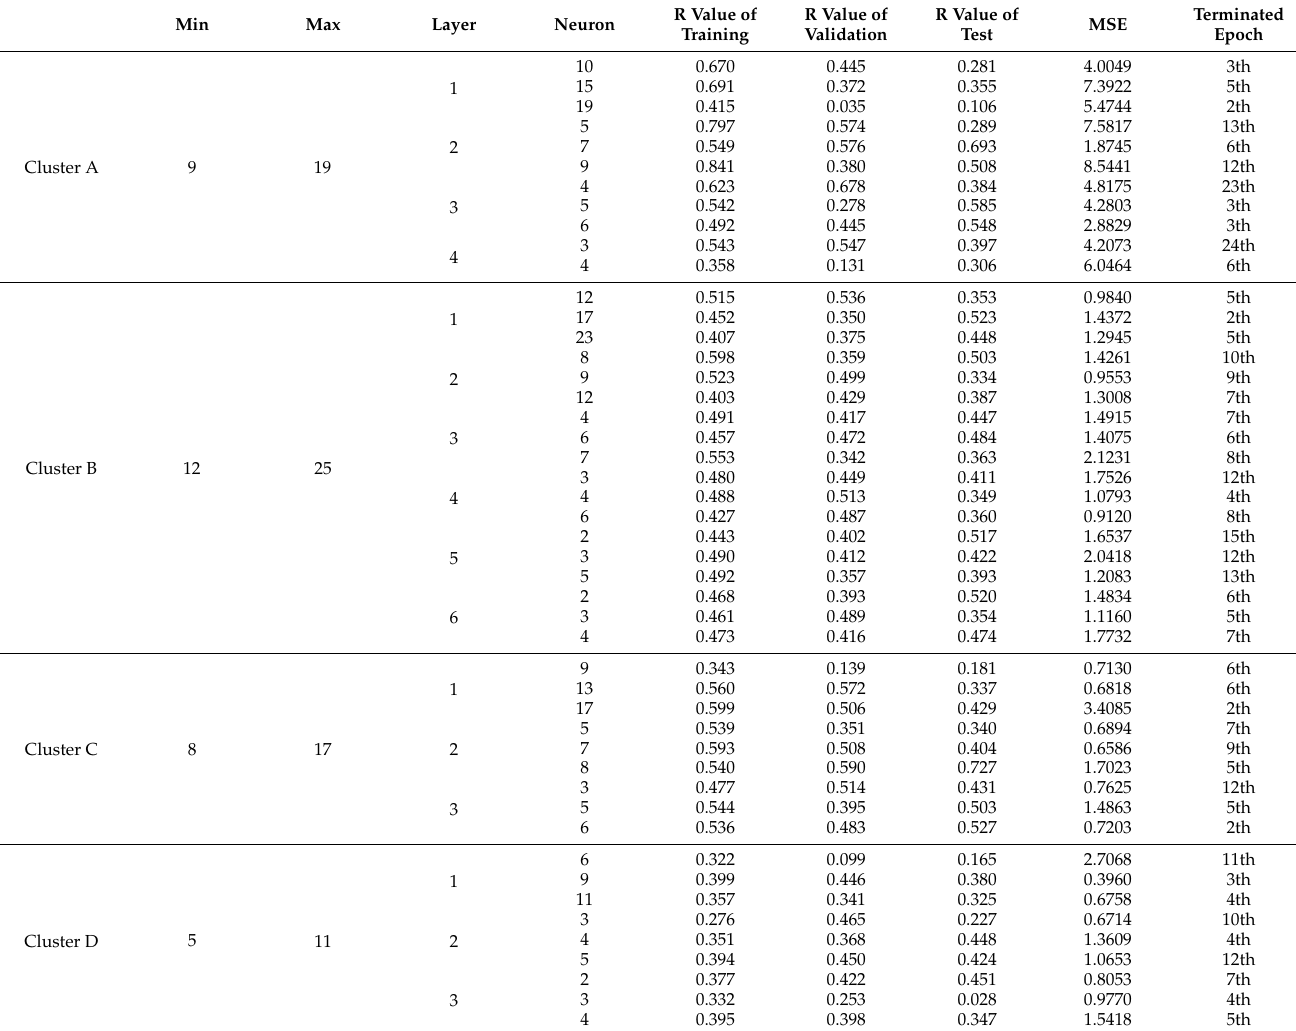
Table 5. Performance of a model to predict theft types by hidden